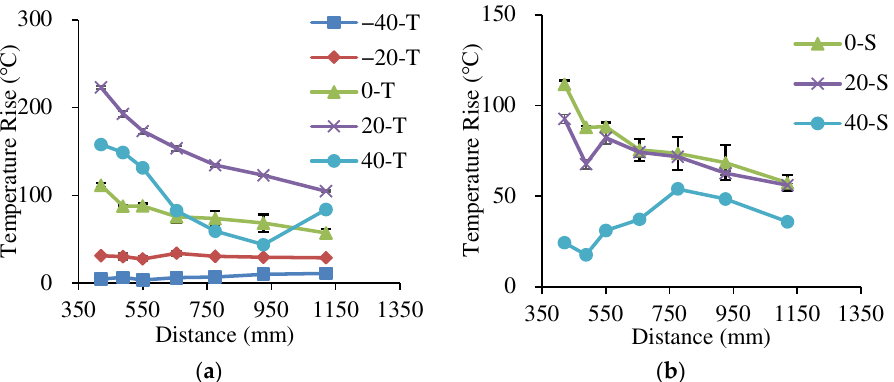
Figure 12. The temperature rise of ( a ) the vertical and ( b ) horizon axis in the exhaust pipe under the fuel flow rate of 10.0 mL/min with the air flow velocity of 10.0 m/s. The heat distribution under the air flow of 10.0 m/s showed an entirely different dis- tribution with that under 2.0 m/s. In the vertical plane, the temperature rise difference between the adjacent points was smaller under 10.0 m/s, indicating a more uniform heat distribution. The point at 20 mm under the air flow velocity of 10.0 m/s showed the highest temperature, indicating that the warm air flow was mainly distributed in the center of the upper region. The temperature rise at −20 mm and −40 mm was much more stable than that under 2.0 m/s, indicating the heat transferred from the upper and central zones was much less than that under low-speed air flow. Thus, the preheating effect of burner flame on the lower zone close to the pipe wall could be ignored.